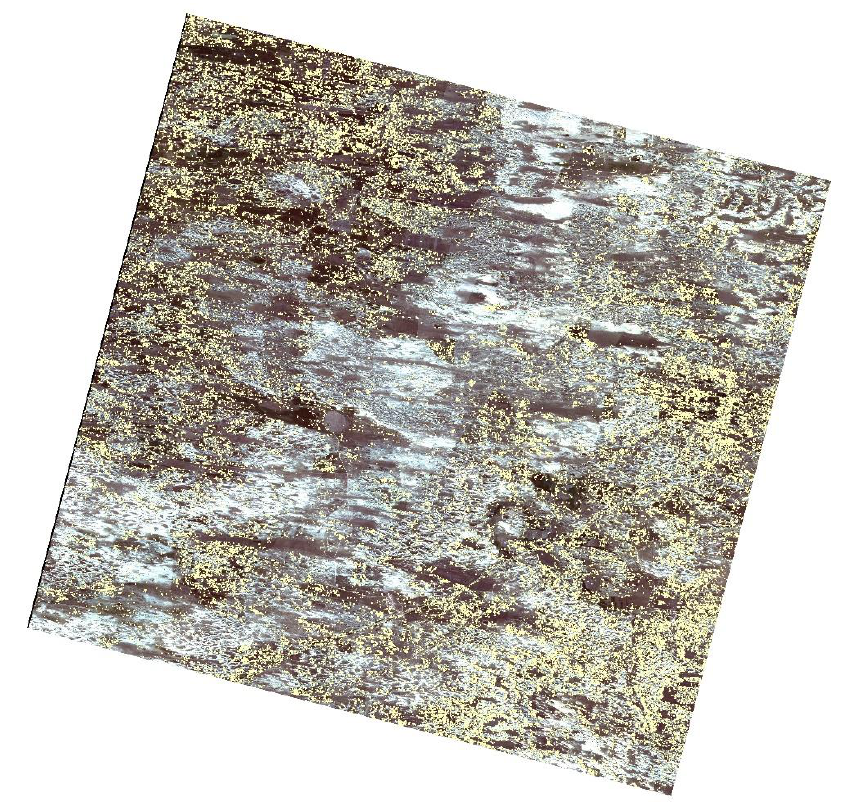
Figure 7. Spatial distribution of sparse Ulmus pumila trees based on fused GF-2 data.